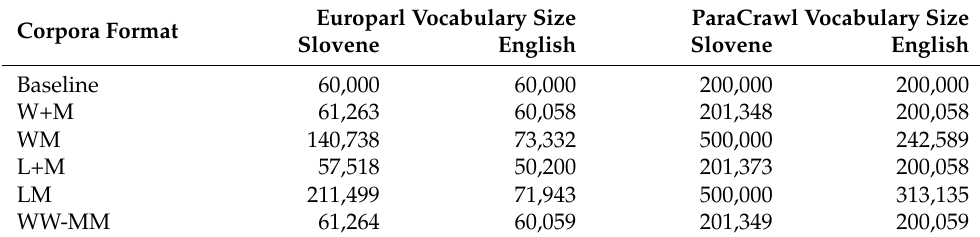
Table 6. Final vocabulary sizes on all tagged formats of the